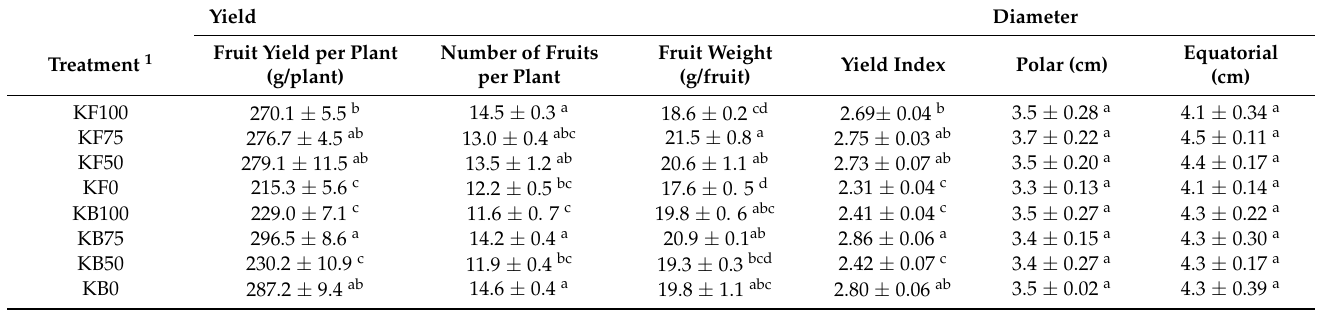
Table 3. Fruit yield parameters in the evaluation of the biofertilizing effect of Acinetobacter cal- coaceticus UTMR2 in tomatillo plants ( Physalis ixocarpa Brot. cv. “c á scara morada”) at different doses of